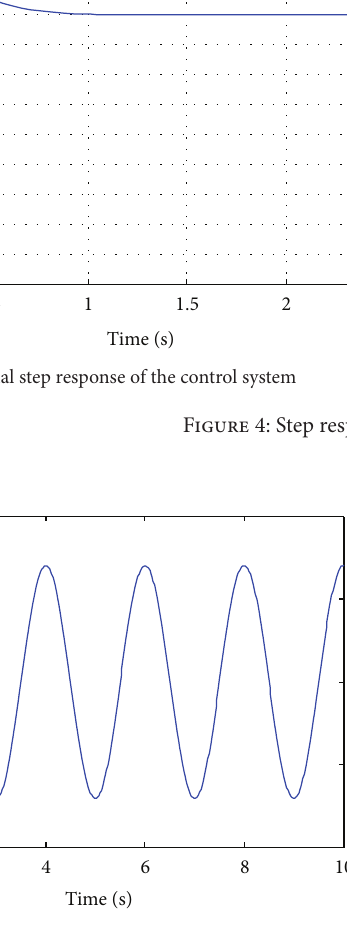
Figure 5: Tracking error of the control